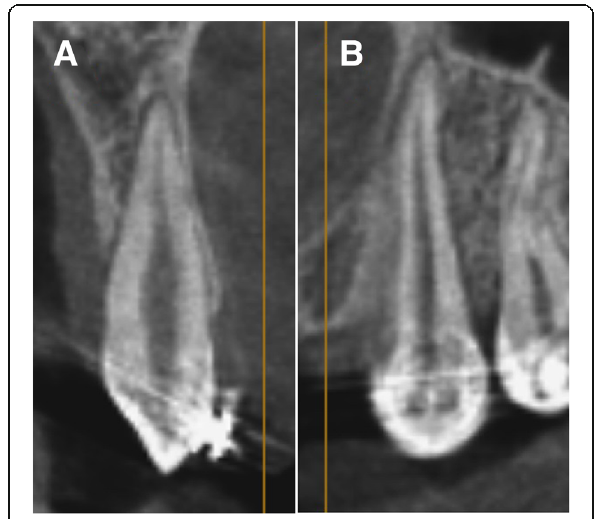
Fig. 4 The canine CBCT image reoriented to show the maximum canine root length in a the labiolingual cross-section and b the mesiodistal cross-section